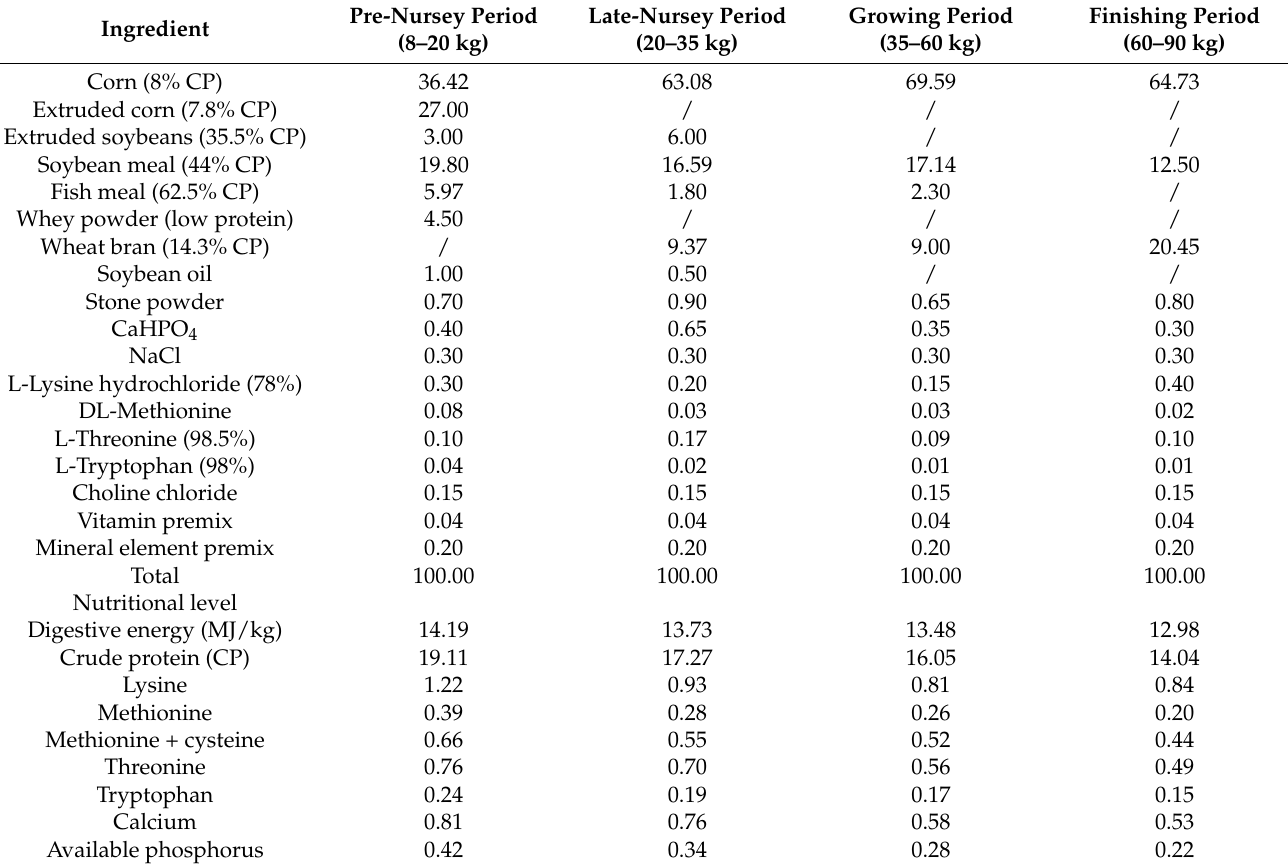
Table 1. Ingredient composition and nutrient levels of diets, % as dry matter